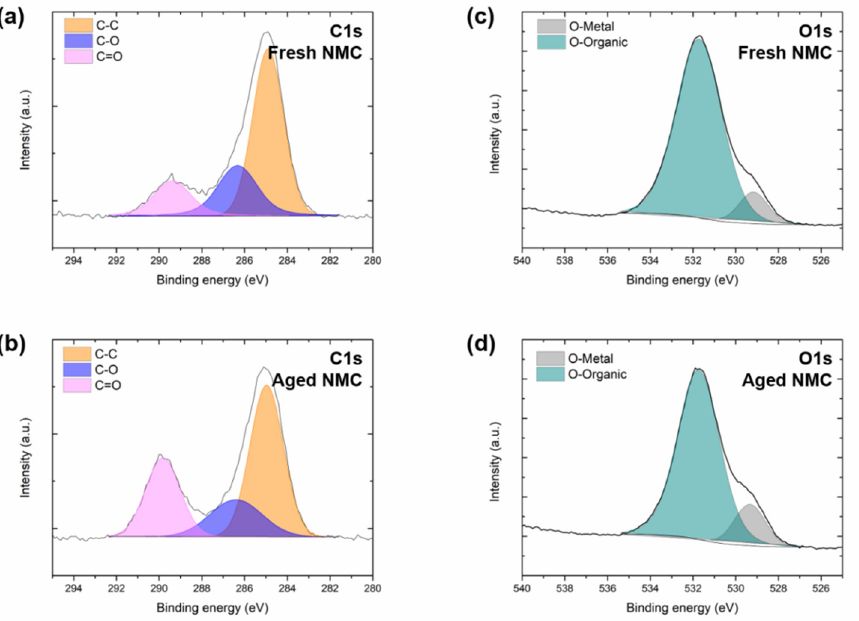
Figure 7. XPS spectra of the NMC powders: C1s region of ( a ) fresh and ( b ) aged NMC powder, and O1s region ( c ) of the fresh and ( d ) aged NMC. O1s region ( c ) of the fresh and ( d ) aged